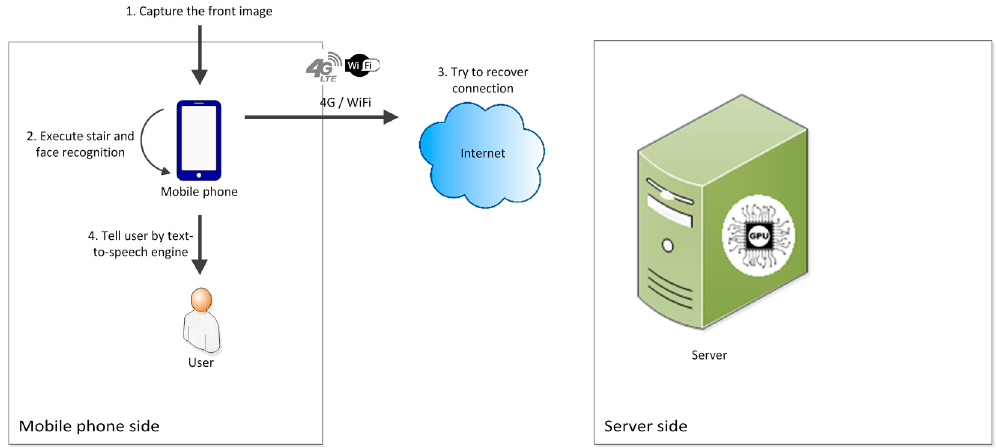
Figure 4. Diagram of data and notification message transmission in the offline mode.